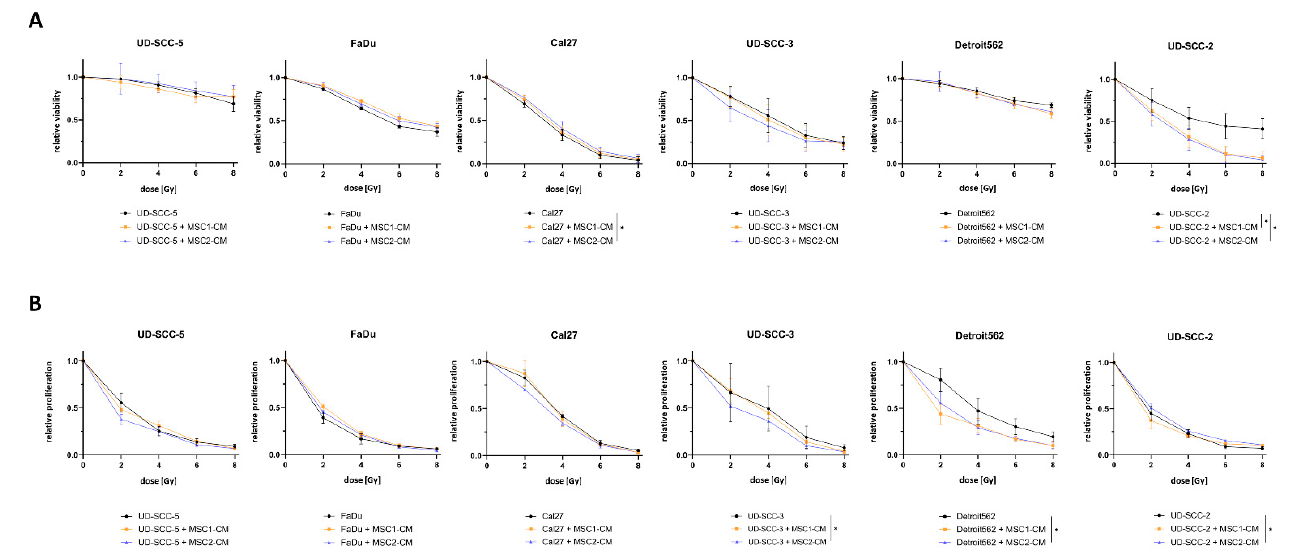
Figure 2. MSC-CM does not increase viability or cellular proliferation in HNSCCs after irradia- tion. ( A ) Relative viability measured by resazurin assays of different HNSCC cell lines at 96 h after irradiation depending on MSC-CM. ( B ) Relative proliferation of HNSCCs at 96 h after irradiation de- termined by trypan blue stainings. HNSCCs were either cultured in HNSCC medium or in MSC-CM. * p < 0.05 (paired t -test).